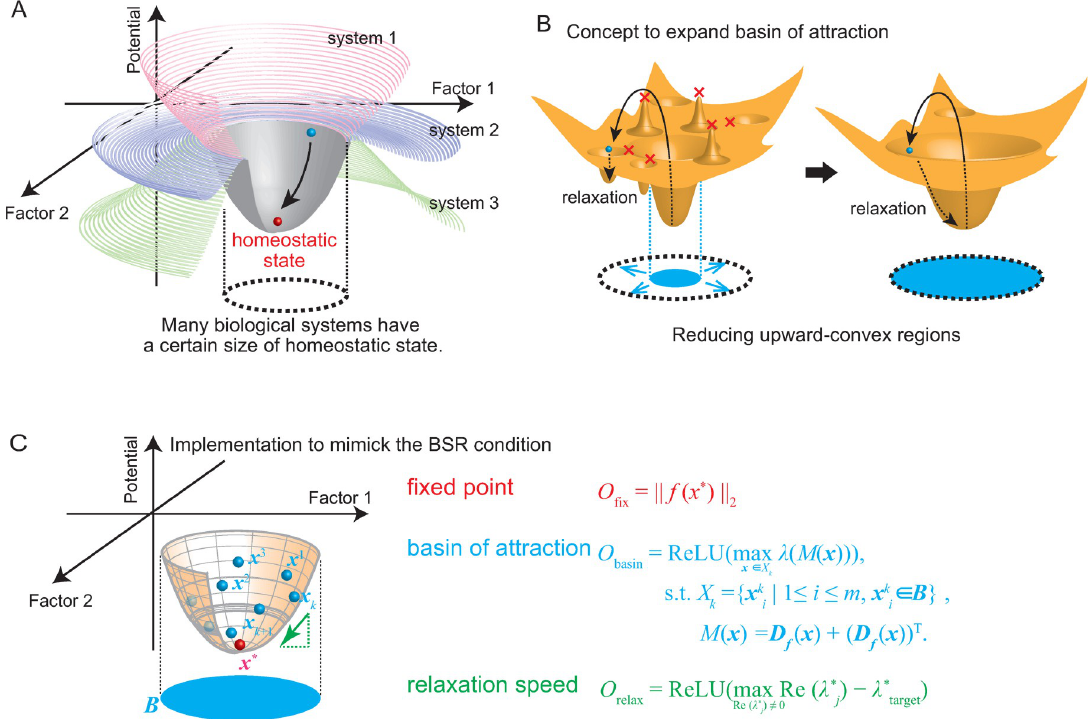
Fig 1. Model of biological system at homeostatic state. (A) Many biological systems behave around a certain stable state. Such stable behavior can be observed in many biological systems although the size of the stable region around the stable state differs by systems. (B) Assumed structure of biological stable region. If there are upward-convex regions in potential focused region, the size of the basin of attraction is limited, therefore, our concept is to diminish such regions in parameter searching. (C) Three factors are considered to search the parameter sets satisfying the BSR condition and incorporated in the objective function to